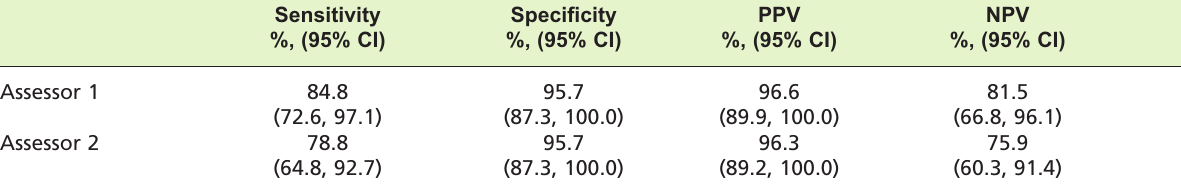
The sensitivity, specificity, PPV and NPV by Assessor 1 and 2 (n=56) Table III: